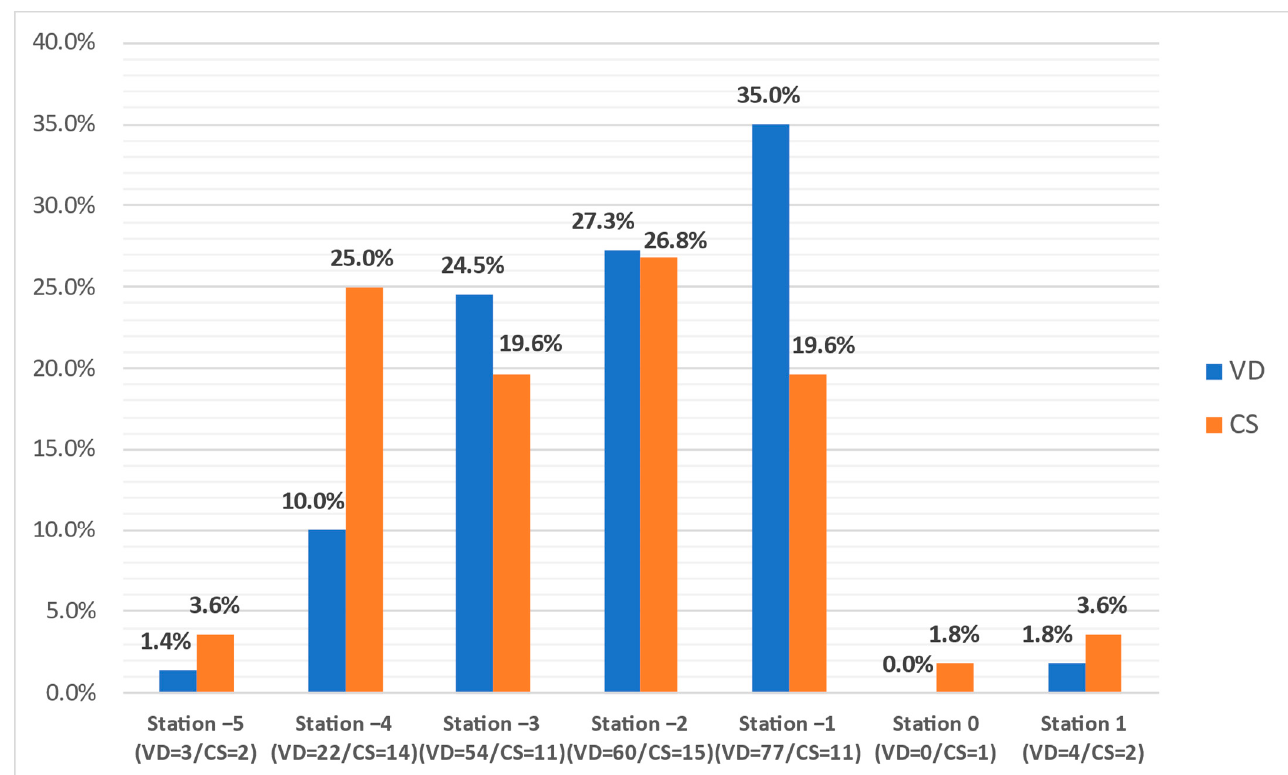
Figure 5. Box plot showing the distribution of the fetal head station in the week before delivery.